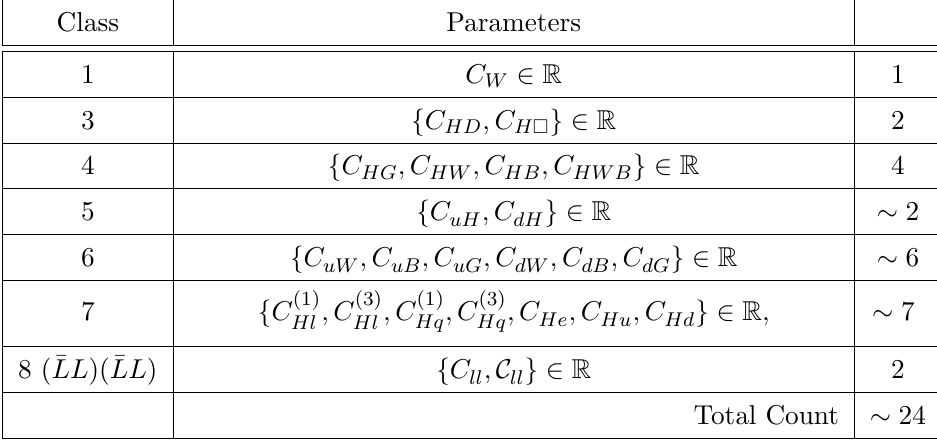
Table 6 . Parameter counts in the U(3) 5 SMEFT for a ‘WHZ pole parameter’ program. The pa- rameter counts that are approximate also rely on expanding numerically in the Yukawa eigenvalues.